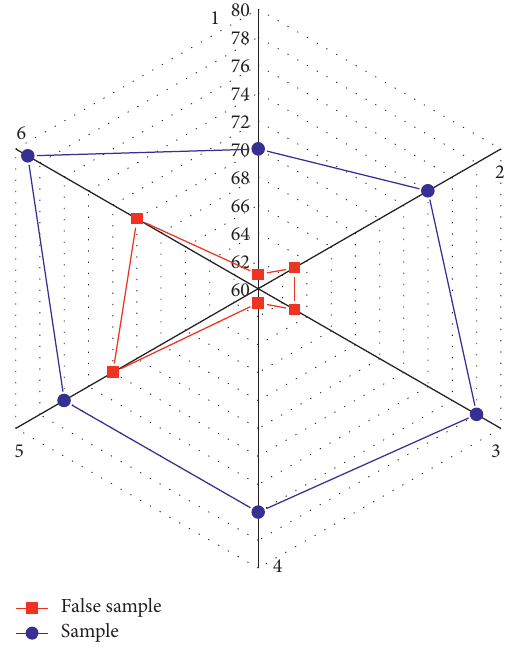
Figure 5: Average division accuracy of FCM algorithm experiments.